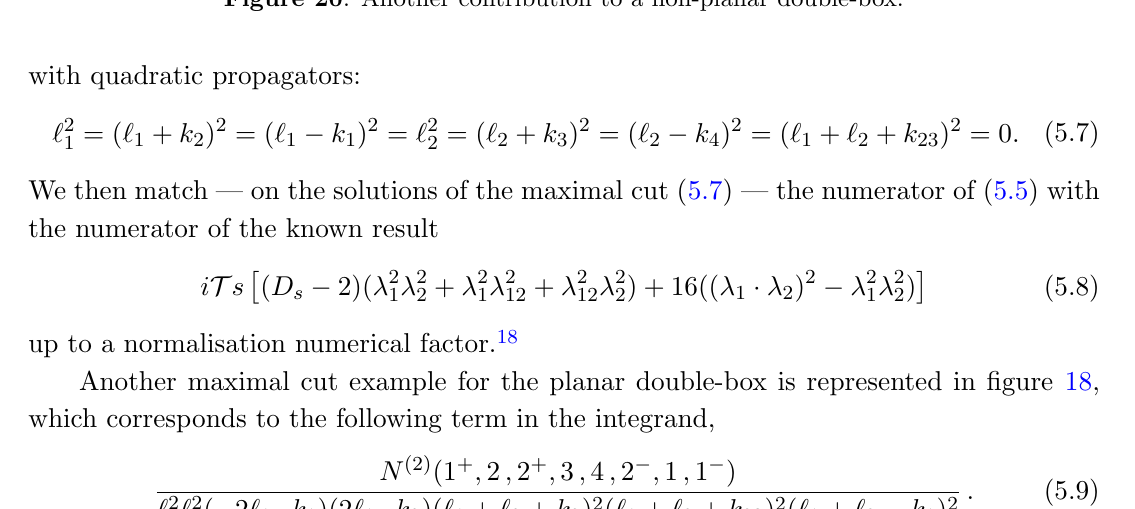
Figure 20 . Another contribution to a non-planar